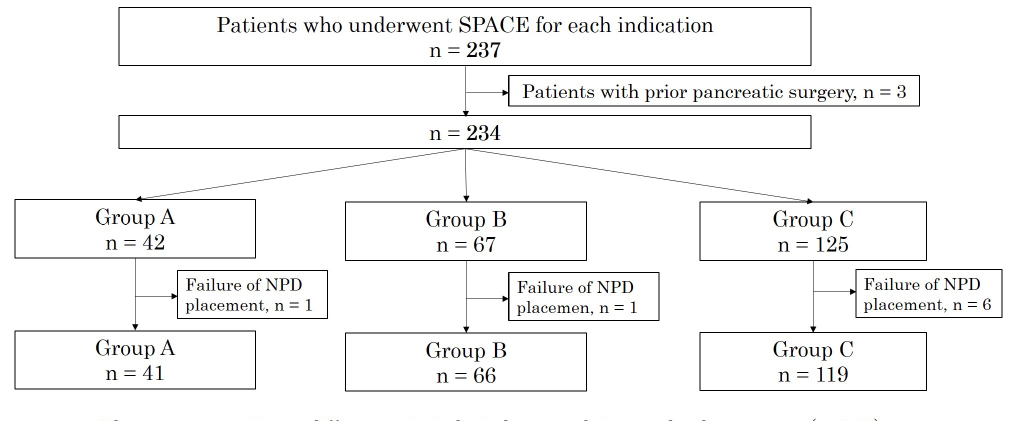
Figure 1. Flow diagram of the study. There were no significant differences in technical success among the three groups ( p = 0.63). Group A included patients with pancreatic masses, Group B included patients without obvious pancreatic masses, and Group C included IPMN patients. IPMN, intraductal papillary mucinous neoplasm; SPACE, serial pancreatic-juice aspiration cytologic examination; NPD, naso-pancreatic drainage.